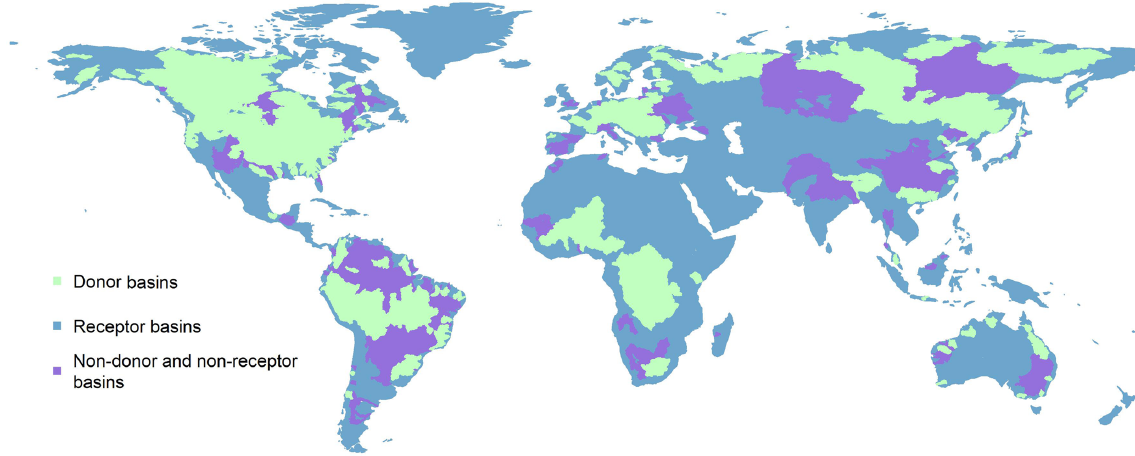
Figure 3. Spatial coverage of donor basins, receptor basins, and non-donor and non-receptor basins.